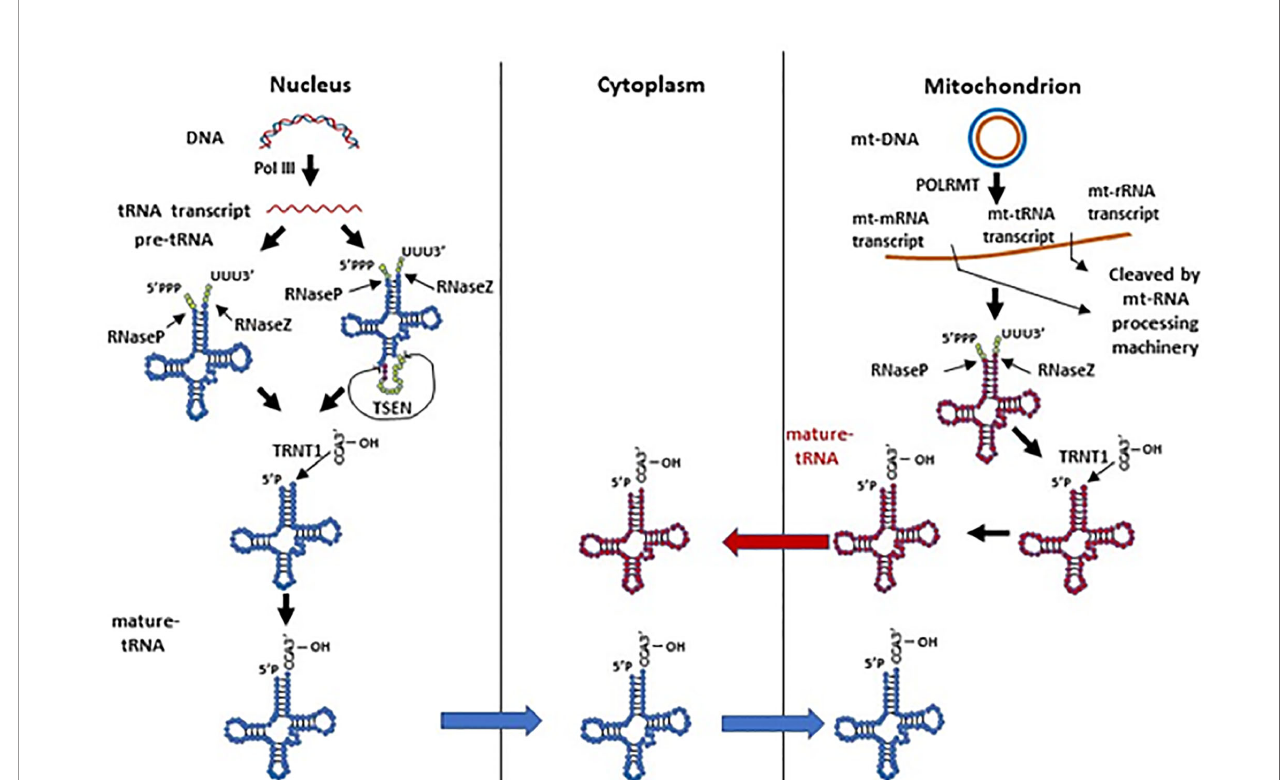
FIGURE 1 | The biogenesis of human nuclear and mitochondrial encoded tRNAs. Pre-tRNAs can be transcribed by Pol III in the nucleus or by POLRMT in mitochondria. The pre-tRNAs have 5 ’ -leader and 3 ’ -trailer sequences, which are trimmed by RNase P and RNase Z, respectively. A minority of nuclear pre-tRNAs have introns, which are spliced by the TSEN complex. A single “ CCA ” sequence is then added to all trailer trimmed 3 ’ -ends of human tRNAs by the TRNT1 protein. Processed nuclear tRNAs are transported to the cytoplasm, while mitochondrial tRNAs predominantly remain in